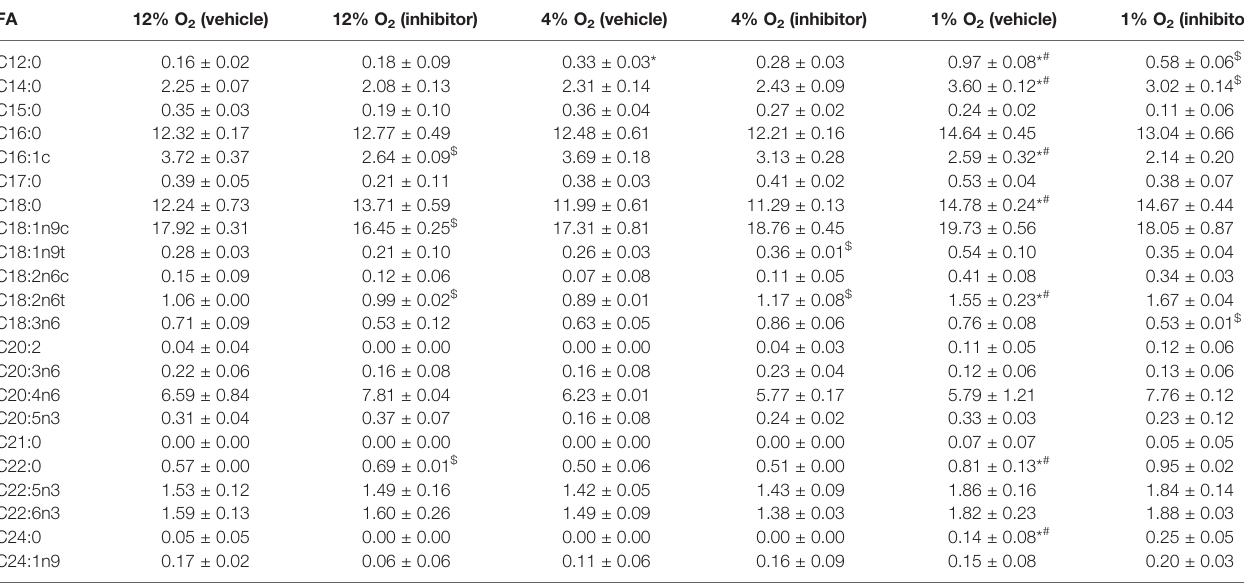
TABLE 1 | The Effect of Hypoxia and ACLY inhibitor on Intracellular Fatty Acid Composition. FA